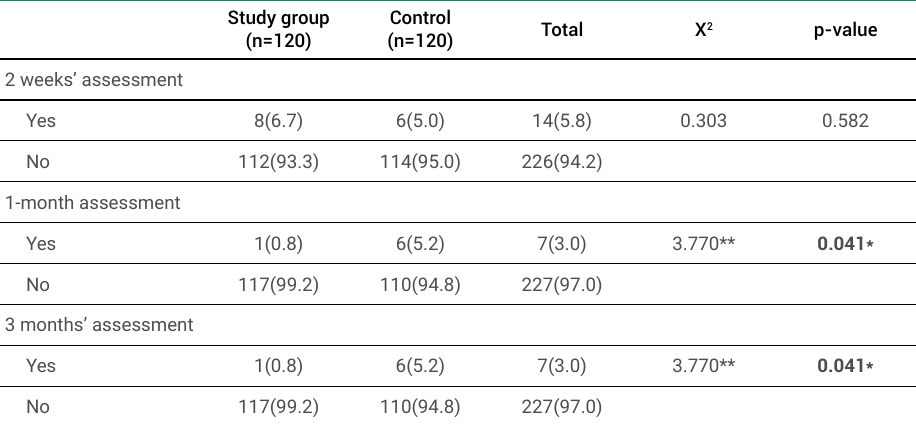
Table 5. Tooth Sensitivity at different intervals of